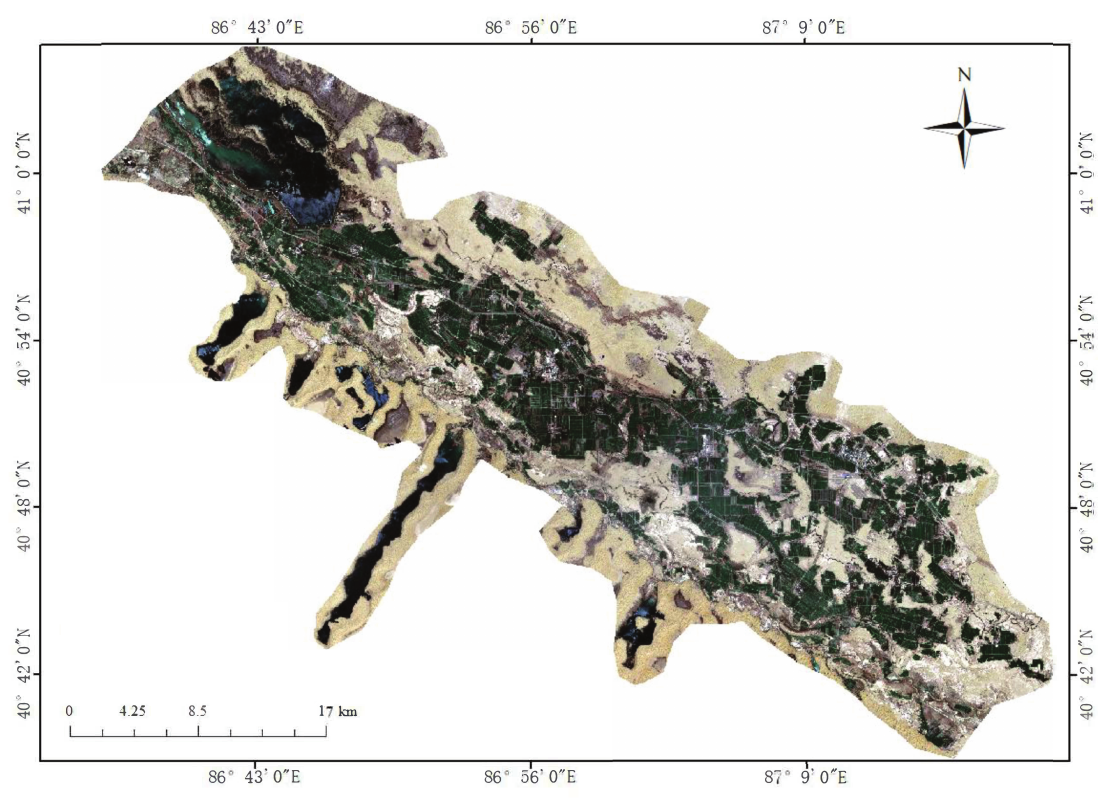
Figure 1. Location of the Study area.